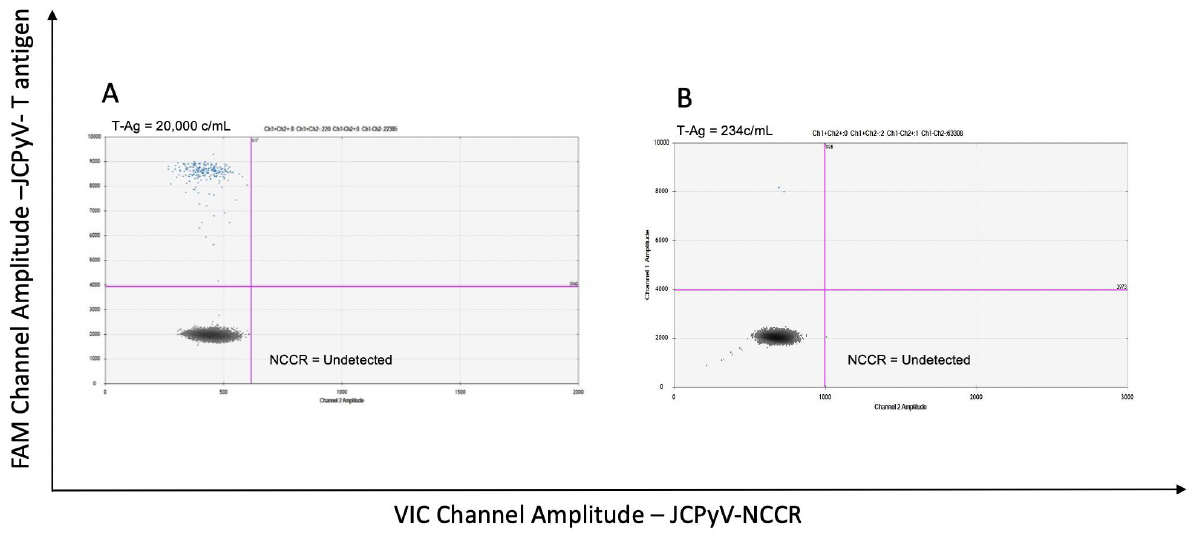
Figure 2. Representative two-dimensional plots of multiplex ddPCR. ( A ) CSF samples from a PML patient that demonstrated the presence of only JCPyV prototype at relatively high JCPyV copy number. ( B ) CSF from another PML patient as an example of a positive run at the lower limit of detection of the assay.